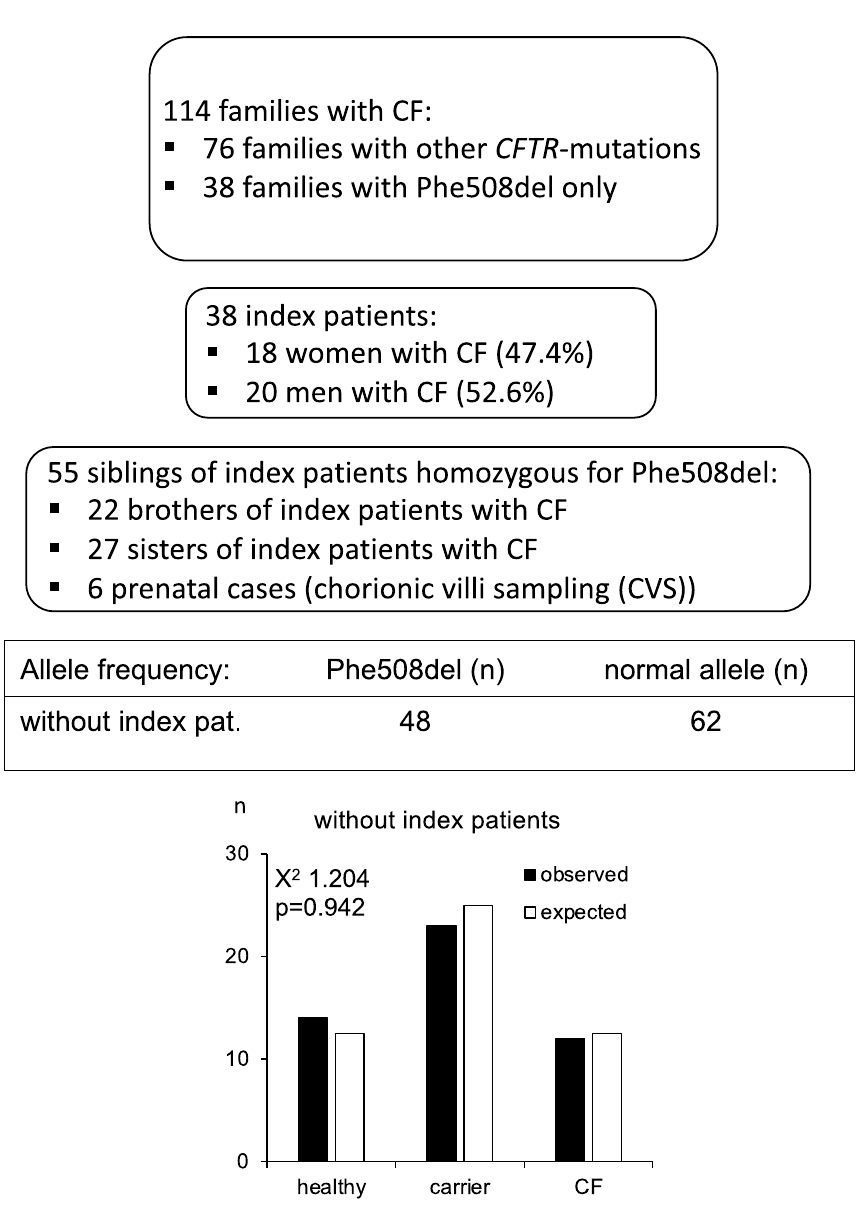
Figure 5. Trio data of 114 families with CF were analysed to demonstrate the inheritance of the genetic trait. In 38 families both parents were carriers of the Phe508del-pathogenic variant leading to at least one child with CF (index patient). Transmission of the mutation to the index patients and to their siblings was analysed (observed) and compared with the Mendelian transmission rate (expected). The distribution of the genotypes was found to correspond to the Hardy–Weinberg equilibrium (X 2 statistic: 1.204, p =